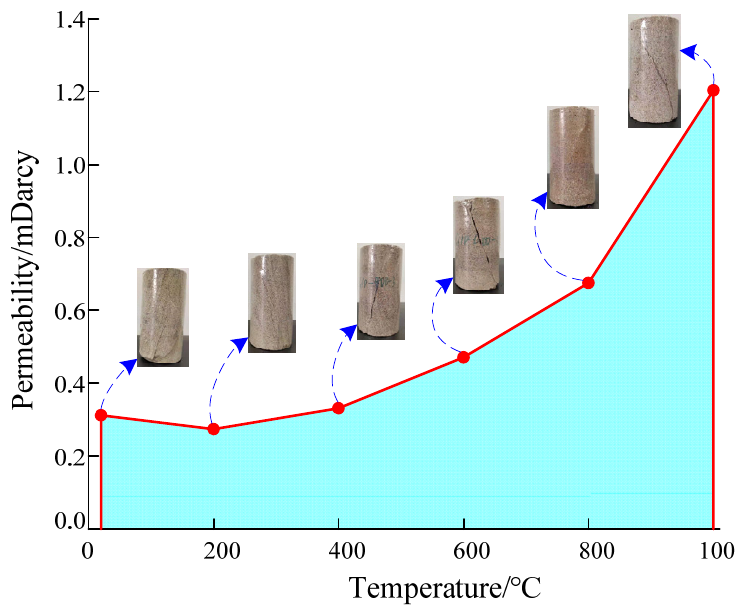
Figure 6. Variation curve of sandstone permeability with temperature.